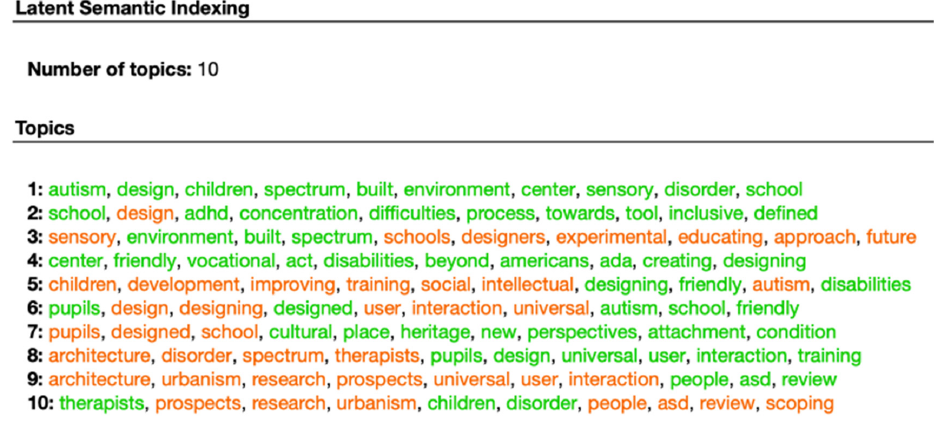
Figure 7. Topic modeling related to 10 scientific documents.